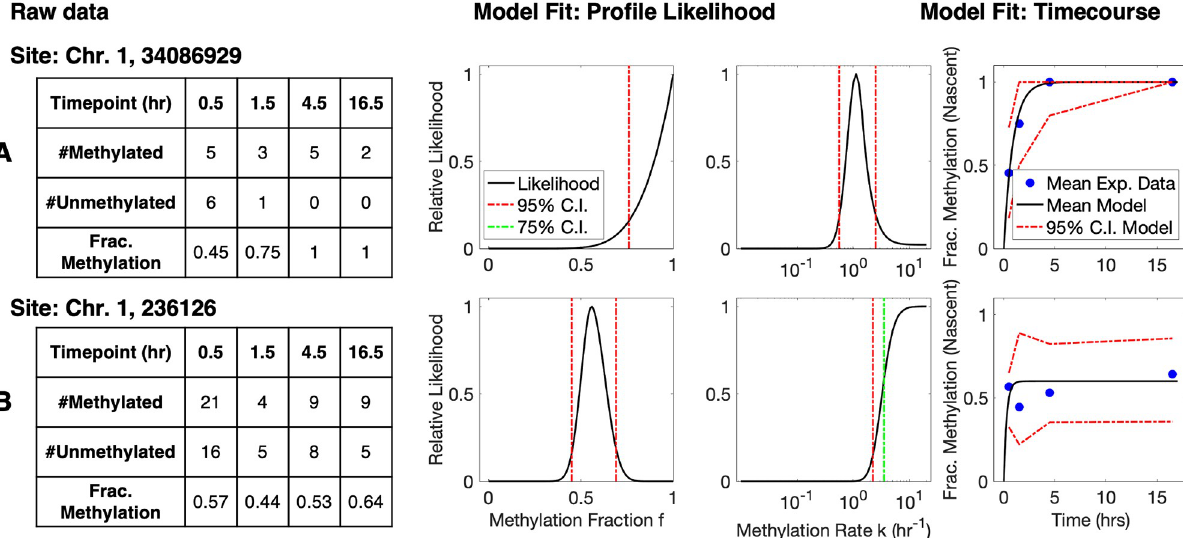
Fig 2. Representative read-data and model fits for twoindividual CpG sites on Chromosome 1. (A: site 34086929; B: site 236126) (left to right: raw experimental data, profile likelihood function for parameter f , profile likelihood function for parameter k , and model-predicted mean timecourse overlaid with experimental datapoints). A : Representative site with a global maximum in k , corresponding to parameter values k = 1.1 hr − 1 ([0.56, 2.5] for the 95% CI) and f = 1 ([0.76, 1] for the 95% CI). The maximum-likelihood model prediction of mean fraction-methylation versus time (right, black curve) is overlaid with averaged experimental data (right, blue dots). The 95% confidence intervals for the model-predicted timecourse are simulated by Eq 2, while accounting for the variable number of samples (reads) at each timepoint. B : A representative site where the remethylation kinetic are too fast to measure, given the time resolution of experiments. In this case, the likelihood function increases to a plateau that extends infinitely in the direction of increased k , and only a lower bound on k can be determined unambiguously. In such cases, we take the lower 75% confidence bound as the parameter estimate for subsequent analysis (see Methods). Thus, the estimated parameter values for this site are k = 3.5 hr − 1 ([2.2, 1 ]) and f = 0.6 ([0.45, 0.69]).